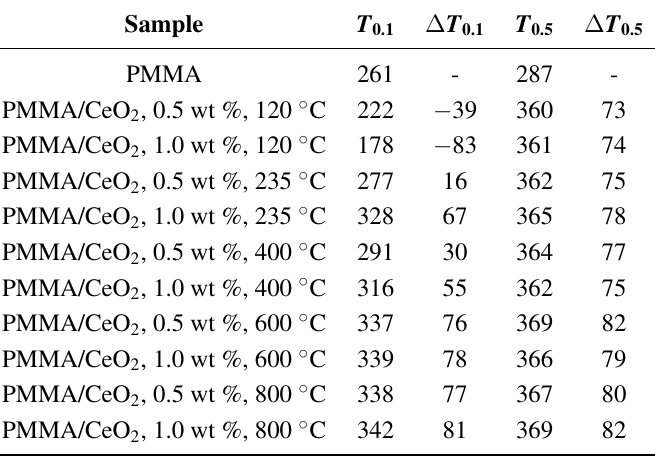
Figure 12. ( a ) TGA and ( b ) DTG curves of pure PMMA and PMMA/CeO 2 hybrid systems. Table 2. Onset and difference temperatures (°C) at 10 and 50 wt % loss of pure PMMA and PMMA/CeO 2 hybrid systems.